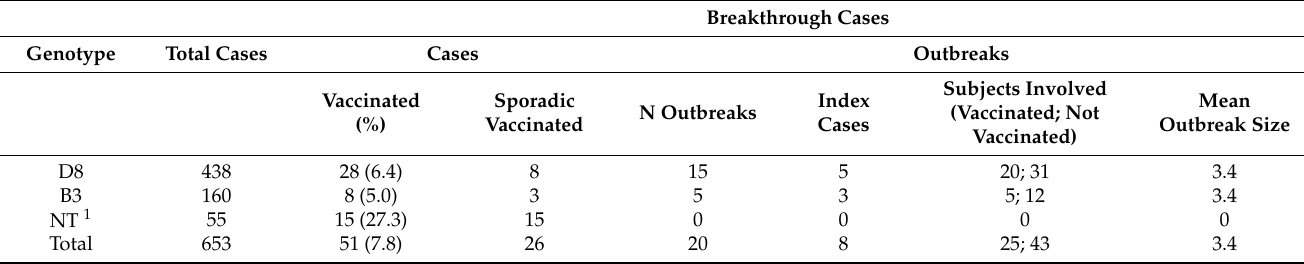
Table 1. Measles cases and their vaccination history in the metropolitan Milan area and its surround- ings during the years